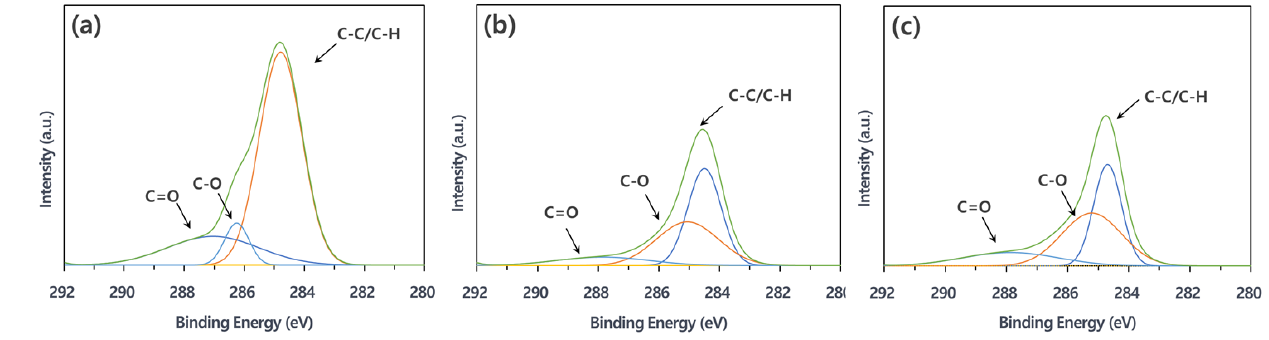
Figure 7. XPS spectrum of C 1s for ( a ) CM-DTHC-300, ( b ) CM-DTHC-500, ( c ) CM-DTHC-700. CM-DTH-300 did not decompose the carboxyl group through the C=O peak